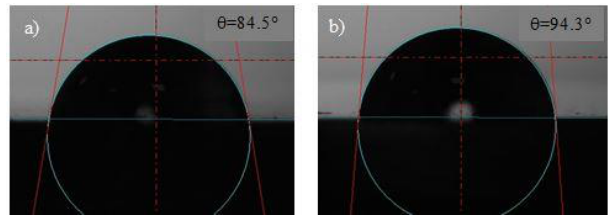
Figure 3. Contact angle measurement, carbon layer (RMS): ( a ) X39Cr13 steel, ( b ) 316LVM steel.